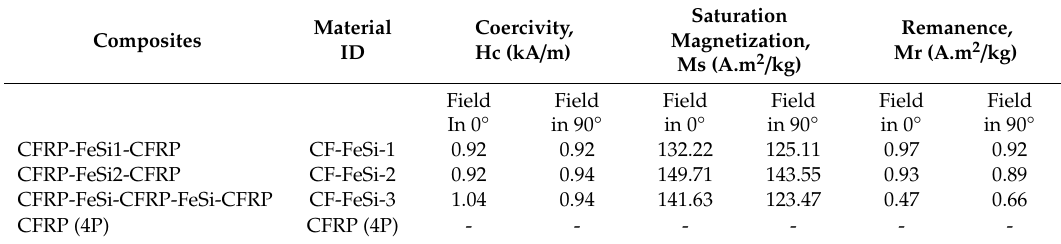
Figure 4. Magnetic hysteresis loops: ( a ) CFRP-pure; ( b ) comparison of hysteresis loops of the CFRP-FeSi soft magnetic composites for the in-plane magnetic field (0 ◦ ); ( c–e ) comparison of hysteresis loops of CF-FeSi-1, CF-FeSi-2 and CF-FeSi-3 for the field applied in the 0 ◦ and 90 ◦ directions, respectively. Table 3. Magnetic properties of the CFRP-FeSi